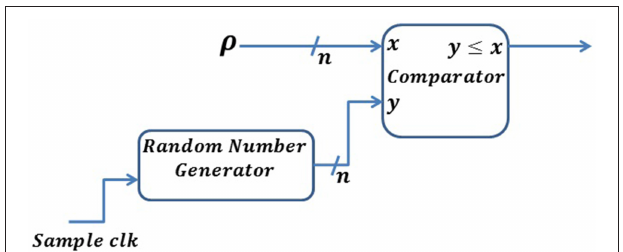
FIGURE 4 | Digital implementation of a Poisson neuron model. An n- bit random number is generated for each sample clk and compared with the spike rate defined by ρ . A spike will be generated whenever the random number is lower than or equal to ρ .